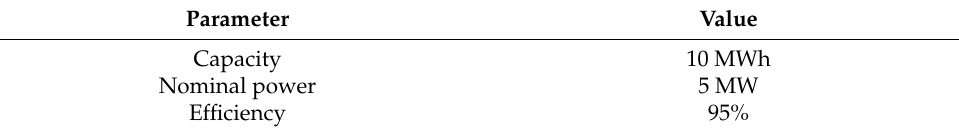
Table 2. BESS parameters.